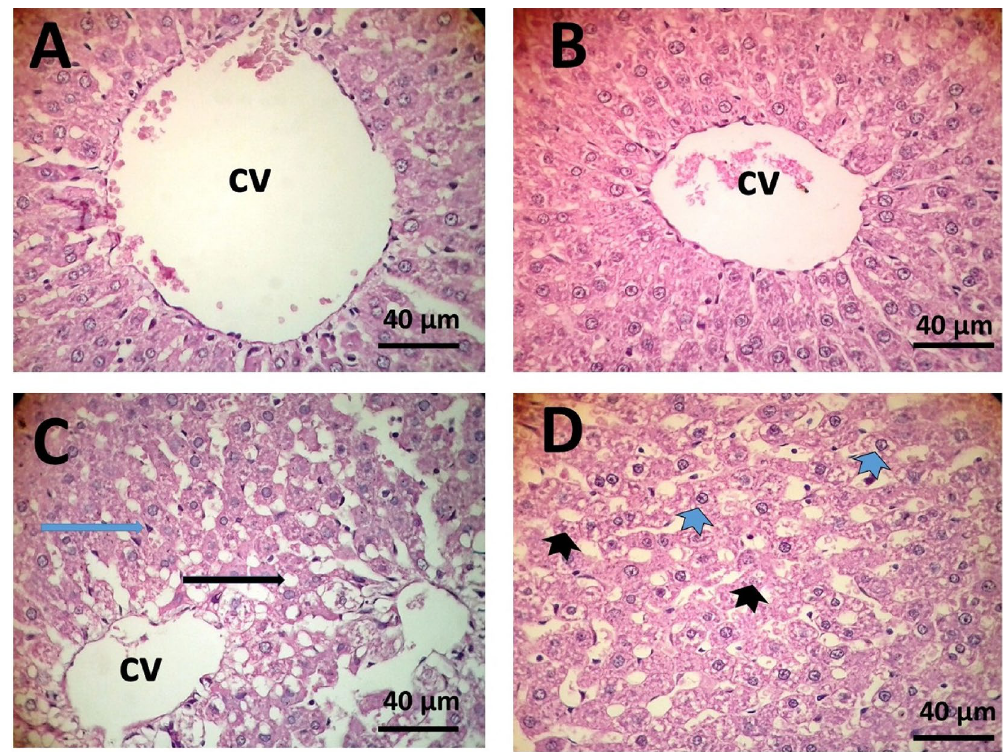
Figure 2. Liver tissue microscopic sections showing normal appearance of hepatic cells radiating from the central vein, dilatation in the central vein (cv) in rats administered tap-water group ( A ); normal appearance of hepatic cells and central vein in rats administered magnetic-water group ( B ); droplet of lipids (black arrow) increase in Kupffer cells (blue arrow) karyolysis of nuclei (black arrowhead), vacuolation of cytoplasm (blue arrowhead) in rats administered microwave-water group ( C and D ). (40×) Scale bar: 40